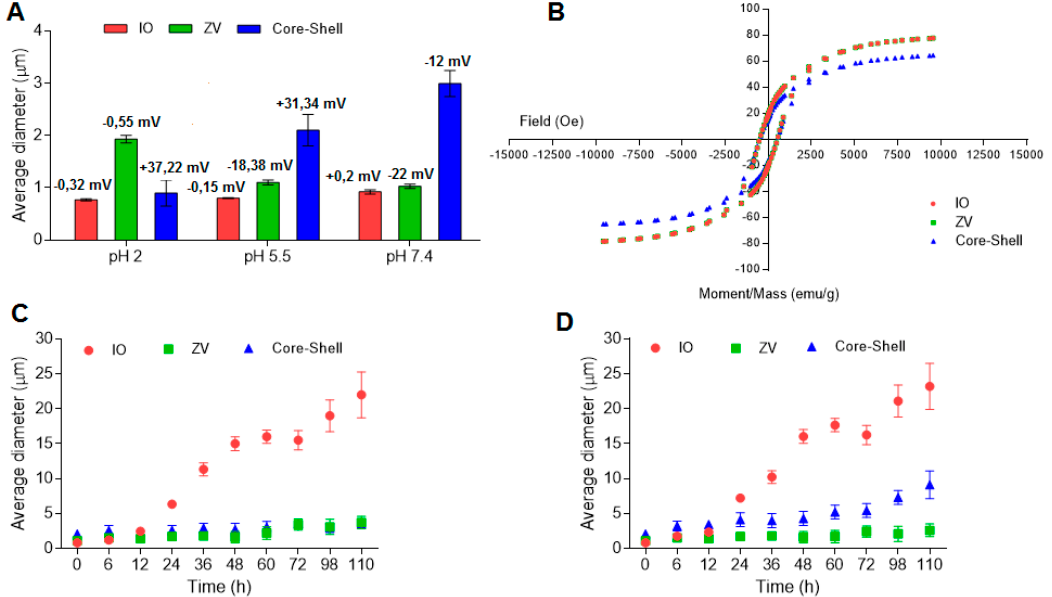
Figure 1. The effects of surface modification ( A ) Influence of the surface modification and polymeric shell on the average diameter and ζ -potential of the microparticles in different media. ( B ) Magnetization curve. Iron oxide (IO) microparticles have been used as a control to evaluate the effect of surface modification (ZV) and the presence of the polymeric shell (core–shell). ( C , D ) Microparticle stability in terms of variation of average diameter versus time ( C ) in preparation medium pH 5.5 and ( D ) at physiological condition (pH 7.4). Values are reported as averages, and the error bars represent the SD (n = 3).